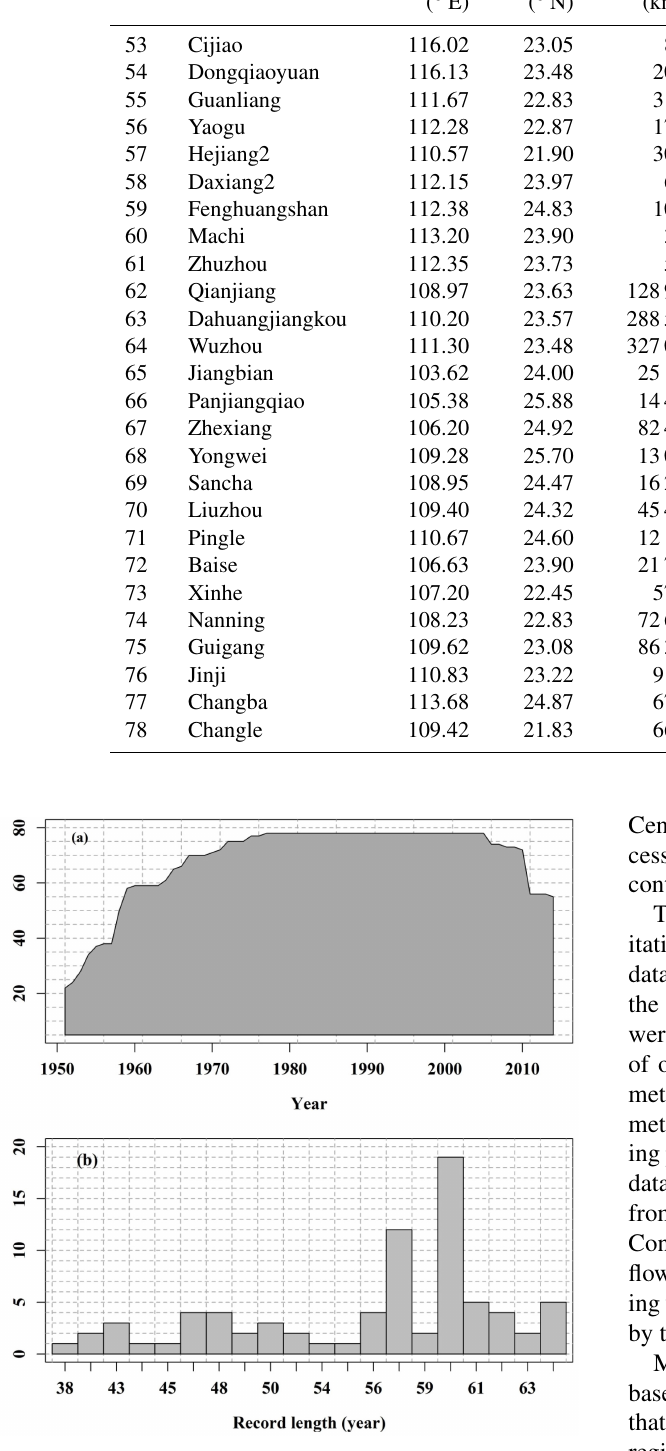
Figure 2. Information on the peak flood flow